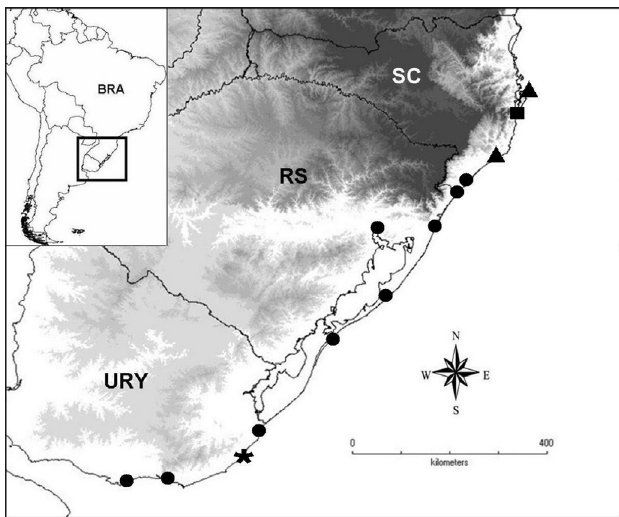
Figure 2. Odontophrynus maisuma Geographic distribution map of . Circles represent records from Rosset (2008) and the square represents the record from Wachlevski and Rocha (2010). The asterisk indicates the type-locality and triangles indicate the present records. Localities recorded for Rio Grande do Sul and Uruguay (Rosset, 2008) from northeast to southwest are (1) Torres, (2) Tramandaí, (3) Porto Alegre, (4) Tavares, (5) Cassino, (6) La Coronilla, (7) Cabo Polonio (type locality), (8) Ruta Interbalnearia km 63, and (9) Carrasco. White areas represent altitudes below 100 m. BRA: Brazil; URY: Uruguay; RS: Rio Grande do Sul; SC: Santa Catarina. The restinga of Baixada do Maciambu is 170 km distant from Balneário Gaivota. Thus, the record from O maisuma Praia do Arroio Corrente fills this gap in the distribution Figure 1. Odontophrynus maisuma of . in the coastal plain of Santa Catarina. The (CHUFSC 1073) from Praia do Arroio record for Ingleses extends its distribution in about 50 km Corrente, municipality of Jaguaruna, Santa Catarina. north of restinga of Baixada do Maciambu, and is the